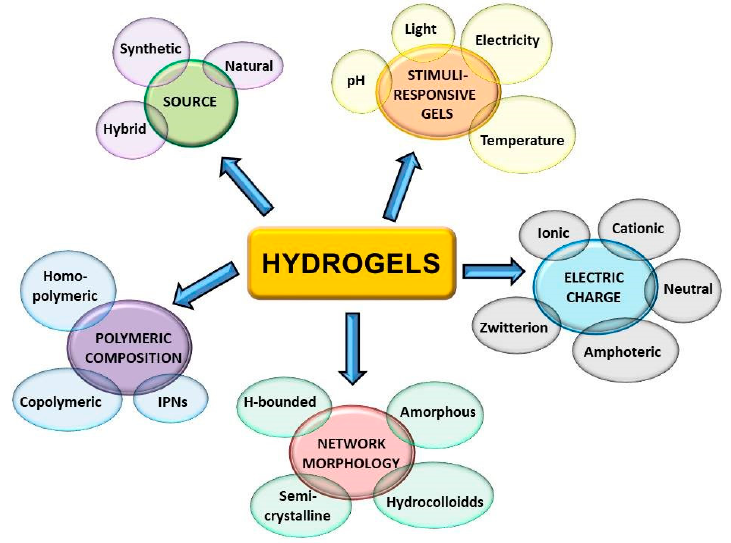
Figure 1. Representation of different classifications attributed to hydrogels according to the source, the polymeric composition, network morphology, electric charge and sensitivity to changes in environmental conditions (stimuli-responsive gels).